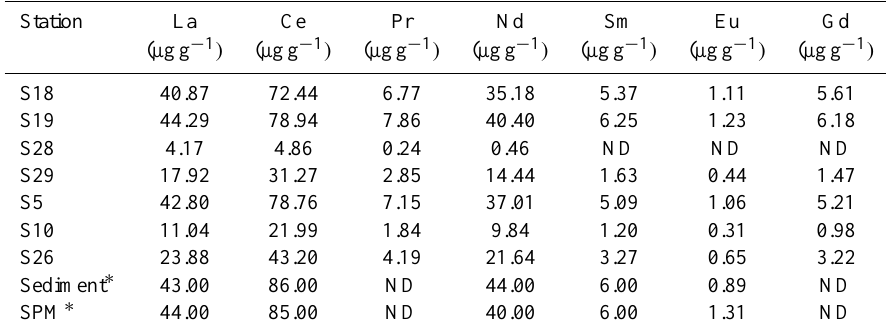
Table 7. Concentrations of light rare earth elements (LREEs) in the sinking particles, sediment and suspended matter (SPM) in the East China Sea.